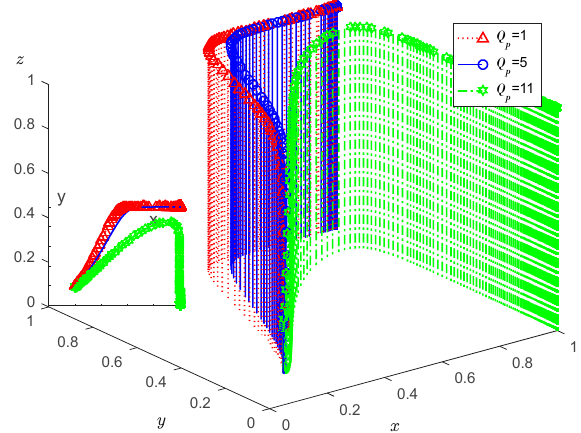
Figure 12. Simulation of evolutionary strategies of processors under different free-riding benefits.